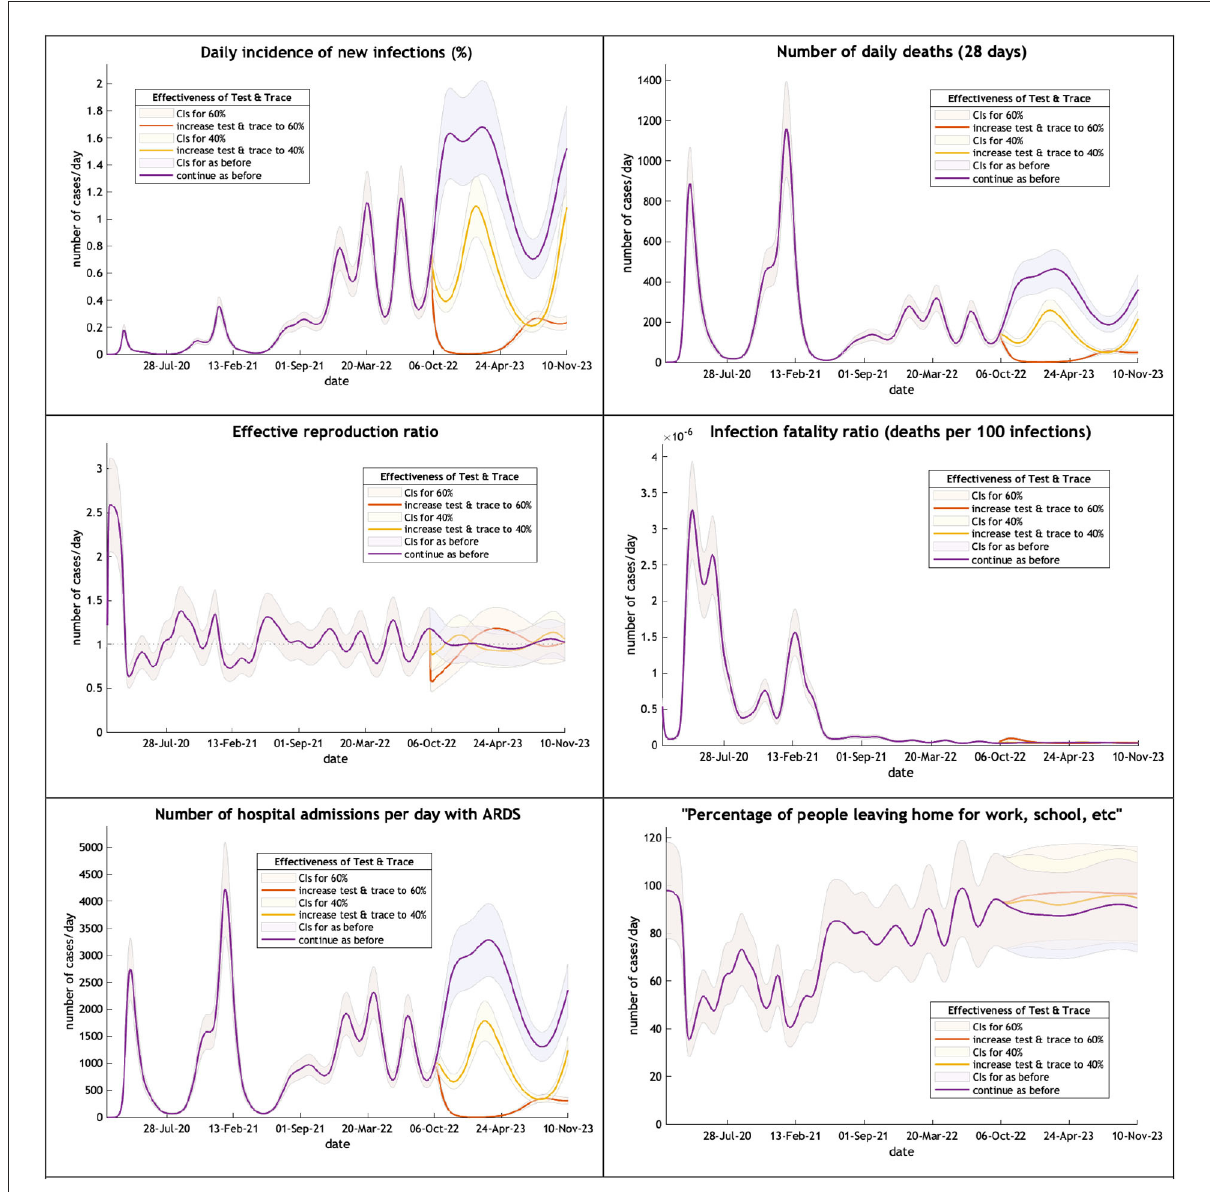
FIGURE2 The UK epidemic curve from February 2020 to October 2023—incidence, deaths, the effective reproductive ratio, the infection fatality ratio, hospital admissions and mobility. Note: Each figure offers three projections: purple if the test & trace system remains as now (24% effective), yellow if the test & trace improves effectiveness to 40%, orange to 60% on 1st October 2022. CIs, 90% credible